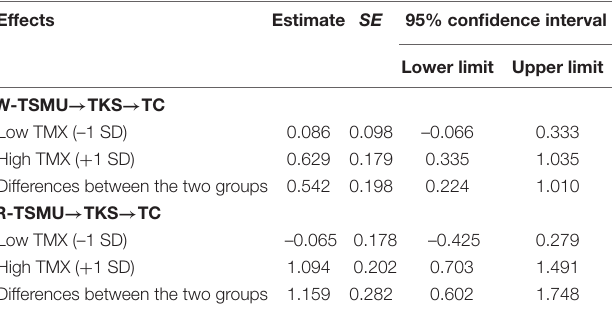
TABLE 5 | Results of moderated mediating effect